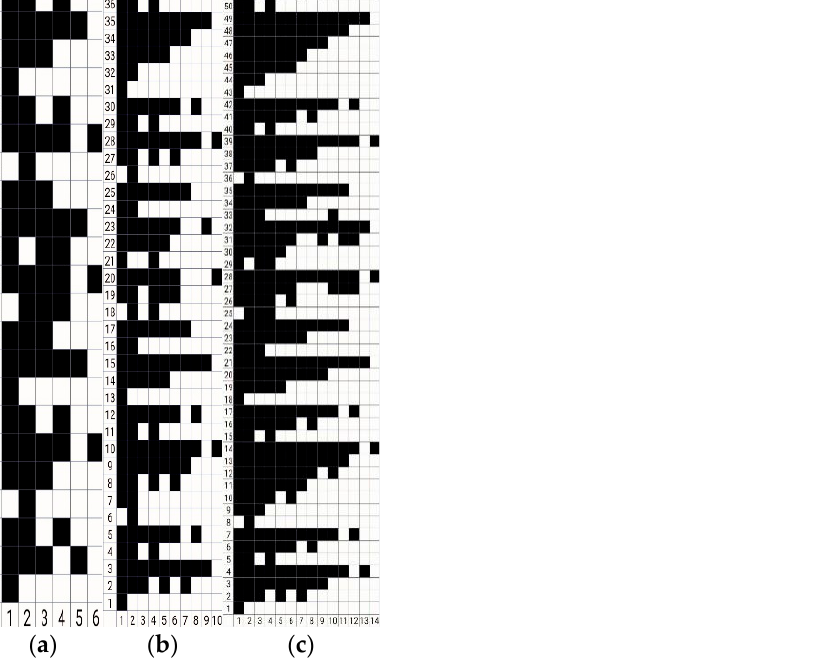
Figure 2. ( a ) Chain draft of 7.5 mm 3-D honeycomb woven fabric; ( b ) chain draft of 15 mm 3-D honeycomb woven fabric; ( c ) chain draft of 22.5 mm 3-D honeycomb woven fabric. honeycomb woven fabric; ( c ) chain draft of 22.5 mm 3-D honeycomb woven